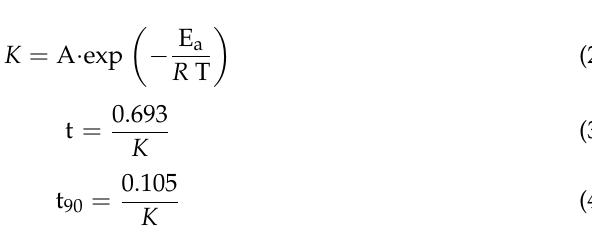
Figure S2: XRPD patterns of a glipizide production batch (a), USP H1H396 (b), USP R09020 (c) and GPZ3h (d) samples. XRPD simulated pattern of GPZ [13] (e), Figure S3: FT-IR spectra of a glipizide